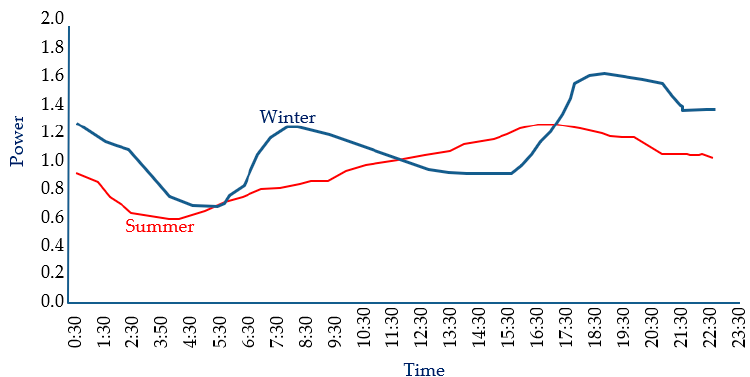
Figure 7. Australian Houses Typical Average Winter and Summer Demands [44]. Table 2. Sample Size of Residential Houses